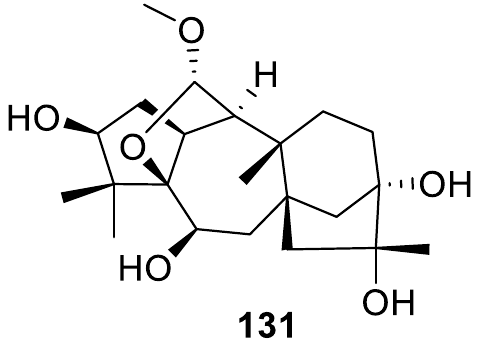
Figure 62. Lanostane-type triterpenoid spirolactones from Ganoderma applanatum .